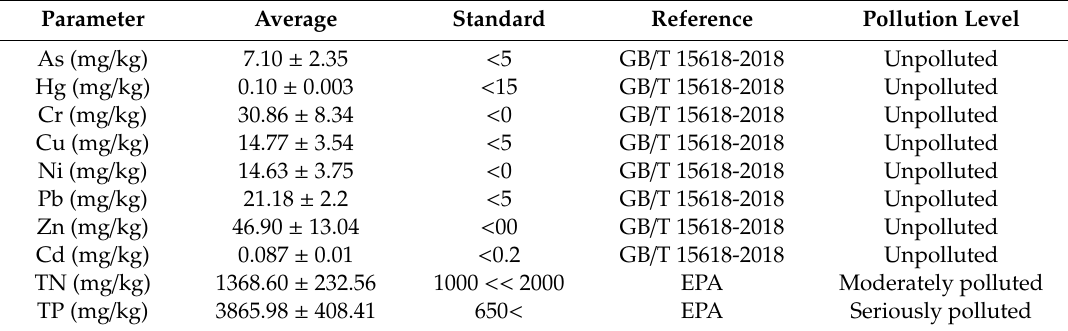
Table 1. The pollution level of contaminants in the sediments of the Yitong River.